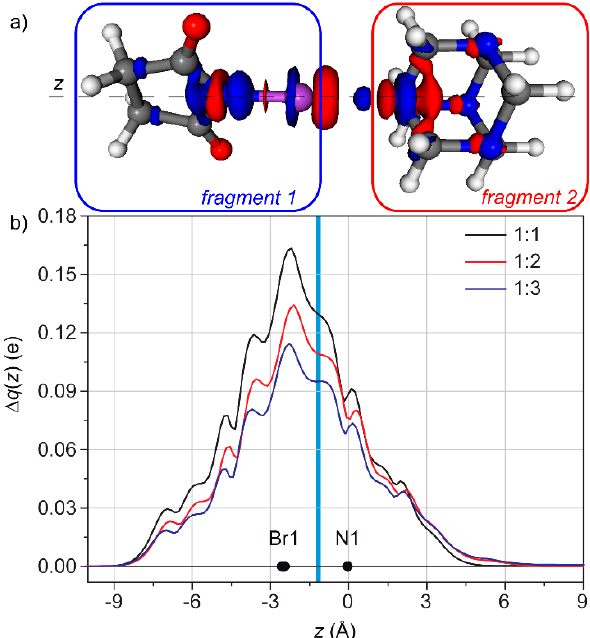
Figure 6. ( a ) 3D contour map of the change of electronic density upon formation of the adduct HMTA / NBS (1:1). Blue (red) isosurfaces identify regions in which the electron density increases (decreases). Density value at the isosurfaces: ± 2 me / bohr 3 . ( b ) CD functions for HMTA / NBS adducts with di ff erent stoichiometry. The black dots represent the z coordinate (or the range of coordinates) of the atoms. The light blue vertical band identifies the range of the inter-fragment boundaries. (Reproduced from Reference 64 with permission from The Royal Society of Chemistry).